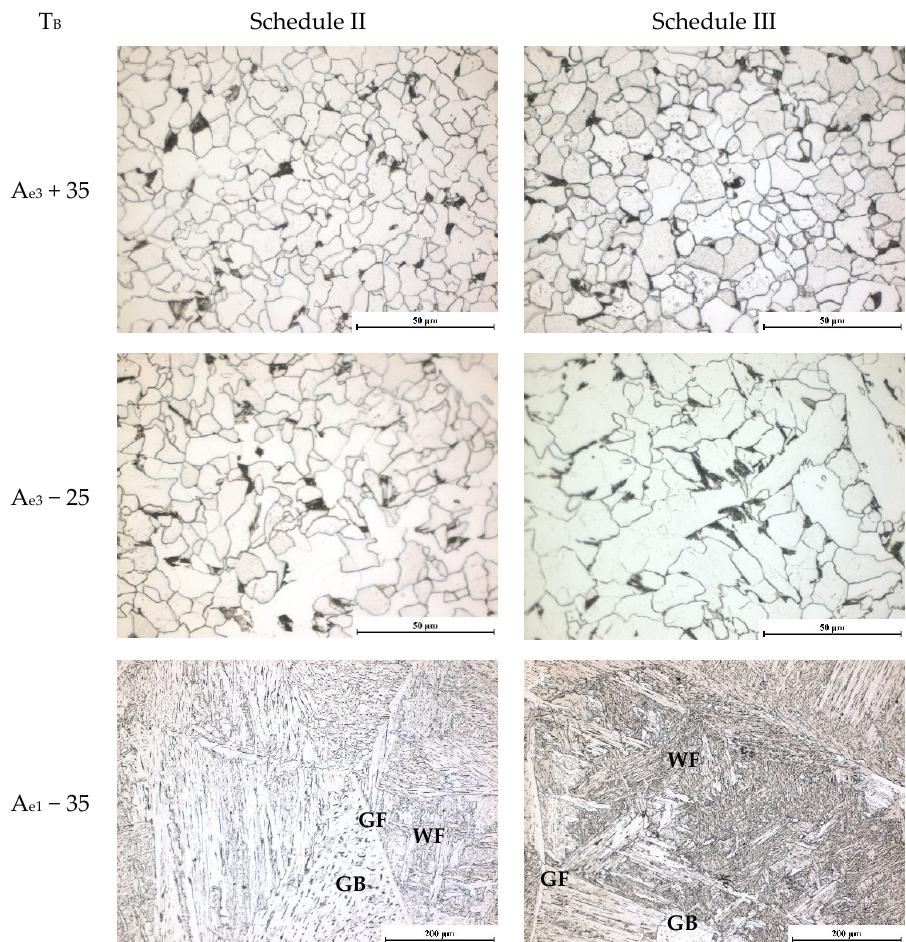
( b ) Figure 9. Micrographs showing different martensite grains formed from prior austenite with different PAGS after quenching from ( a ) 1350 °C and ( b ) 820 °C for alloy C.